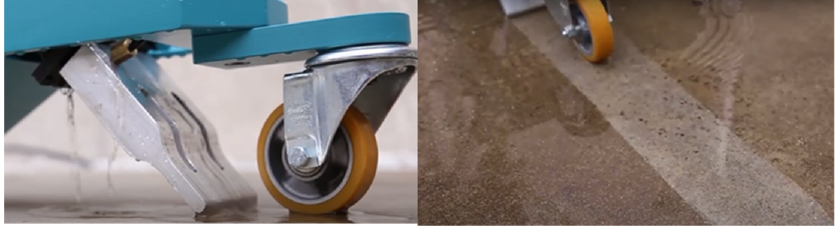
Figure 2. This illustrates non-immersion floor cleaning using the cleaning device. The picture on the left shows the sonotrode tips assembled on a trolley. The picture on the right shows the same device cleaning a dirty floor by sweeping the sonotrode. The difference between the dirty and clean areas is clearly visible to the naked